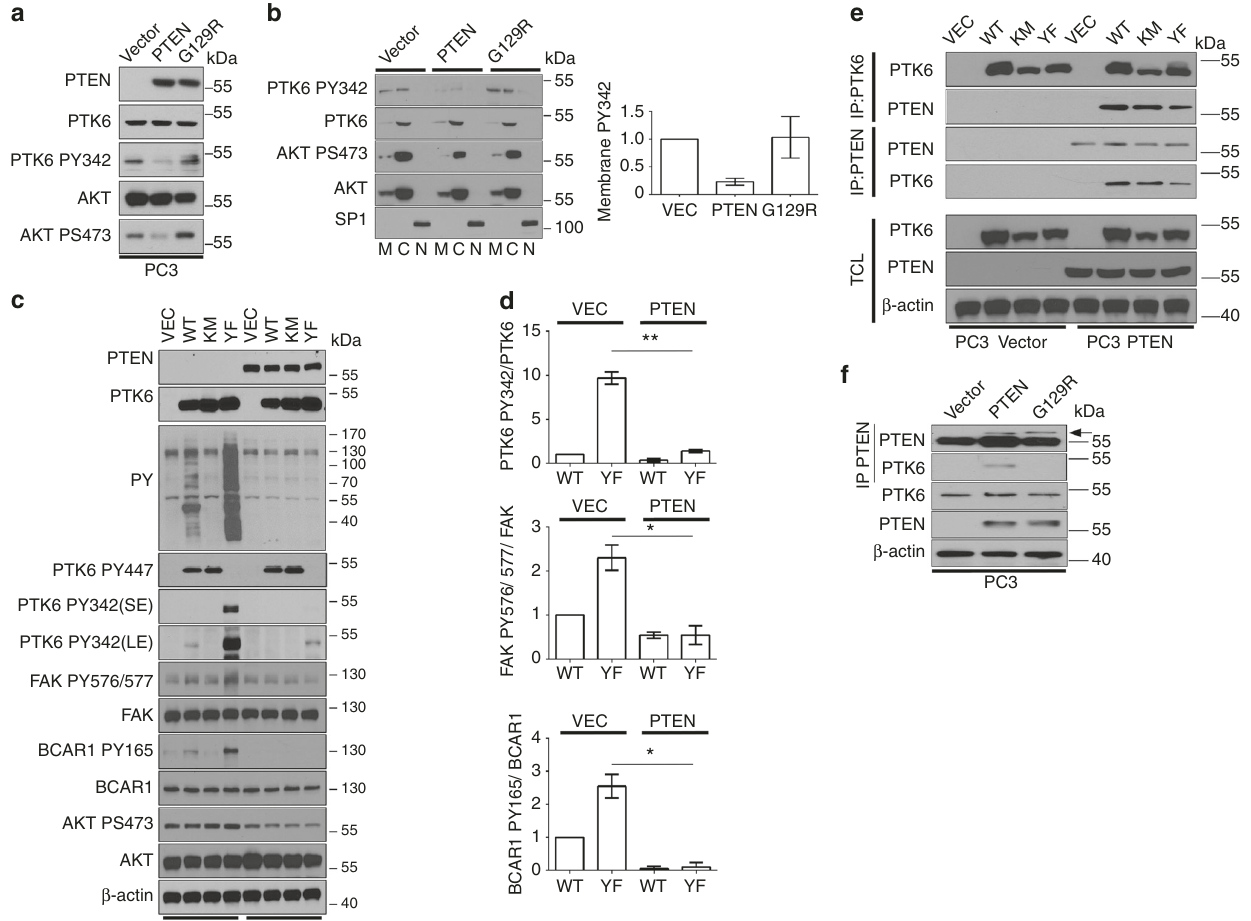
Fig. 1 Expression of PTEN reduces PTK6 activation in PC3 cells. a Total cell lysates were prepared from PC3 stably expressing empty vector, PTEN, or PTEN G129R. Lysates were subjected to immunoblotting and changes in active PTK6 (PY342) and AKT (PS473) were monitored. b PC3 cells stably expressing empty vector, PTEN, or G129R were fractionated into membrane, cytoplasmic, and nuclear compartments. Immunoblot analysis was performed with active PTK6 (PY342 PTK6) and total PTK6. PTEN activity was monitored by active AKT signal (PS473 AKT) compared to total AKT. SP1 was used as a nuclear marker control. Activated PTK6 at the membrane was quanti fi ed ( n = 3). c Empty vector, wild-type (WT), kinase-dead (KM), or constitutively active (YF) PTK6 constructs were transiently expressed in PC3 cells stably expressing empty vector or PTEN. Total cell lysates were prepared and subjected to immunoblotting. Tyrosine phosphorylation (PY) of proteins was assayed with a mixture of anti-phospho-tyrosine antibodies, PY20 and 4G10. Activation of PTK6 substrates was measured with phospho-speci fi c antibodies. d The relative effect of PTEN expression on activation of PTK6, phospho-FAK, and phospho-BCAR1 was quanti fi ed ( n = 3, ** P < 0.01, * P < 0.05). e MYC-tagged empty vector (Vec), wild-type (WT), kinase-dead (KM) or constitutively active (YF) PTK6 recombinant mutants were immunoprecipitated from PC3 cells stably expressing empty vector or PTEN. Bound protein was measured by immunoblot. f PTEN was immunoprecipitated from PC3 cells stably expressing empty vector, PTEN, or PTEN G129R. Complexed proteins were assessed by immunoblot. Arrowhead denotes protein of interest. The heavy band at 55 kDa is background and represents